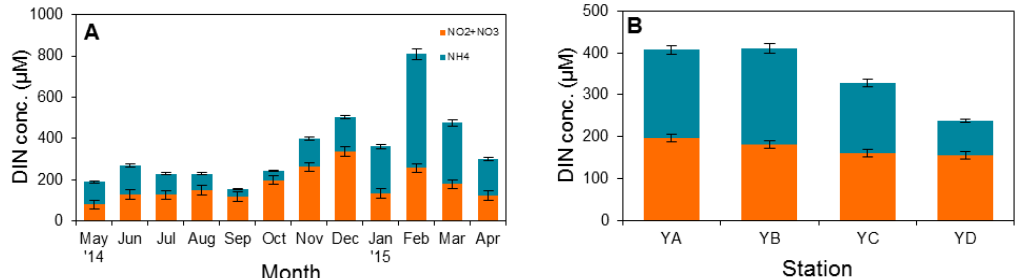
Figure 3. Average ( A ) monthly and ( B ) spatial variations in dissolved inorganic nitrogen (DIN) concentrations in the upper Youngsan River estuary. Error bars represent standard deviations.